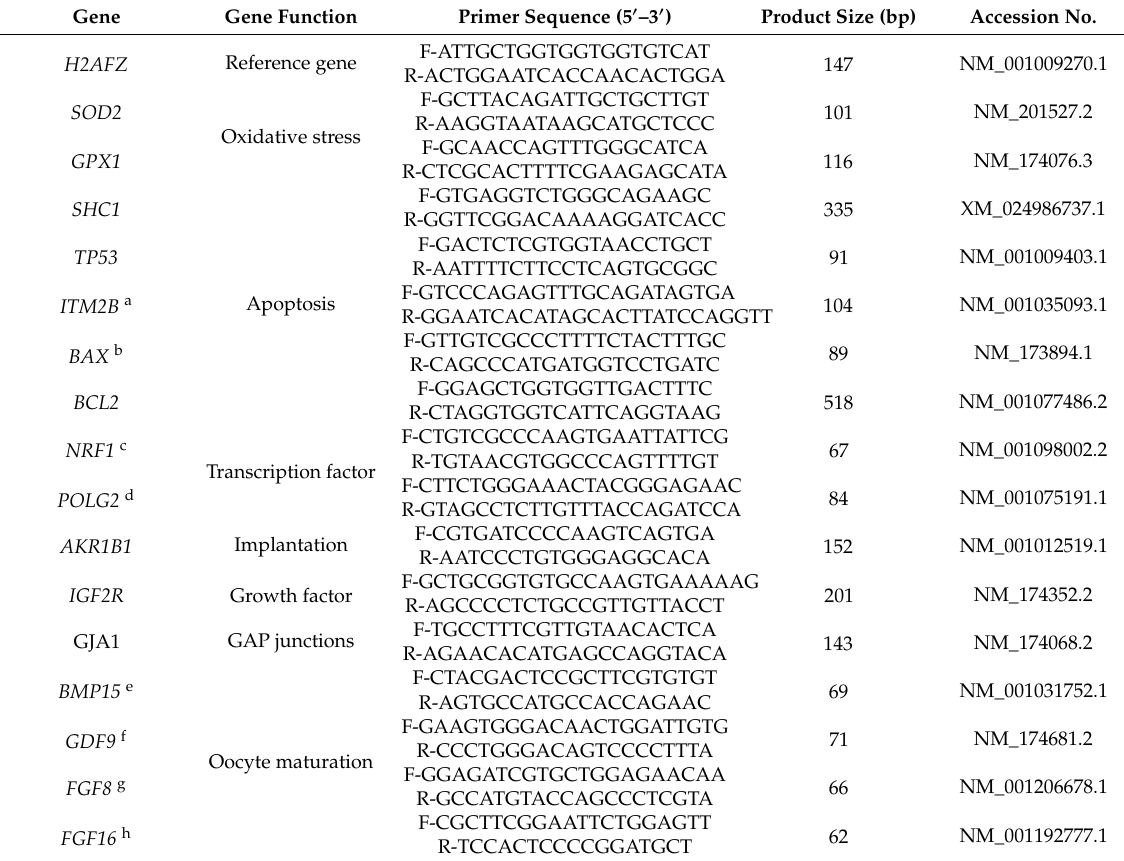
Table 1. Details of primers used in this study for